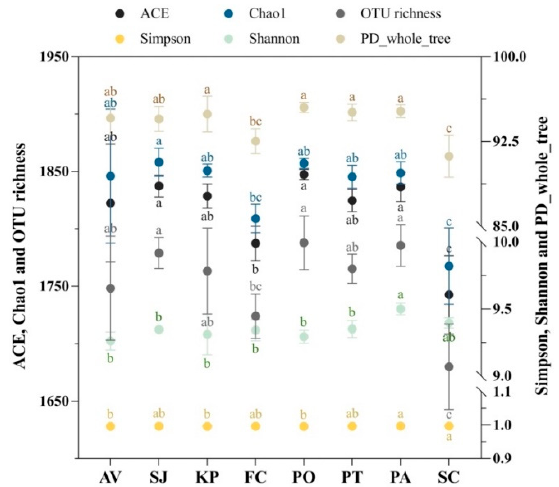
Figure 5. Rhizosphere bacterial community α -diversity in different stands. Data present means ± st. errors; different letters (from a to d) in figure body indicate significant differences among tree species after Duncan’s test ( p < 0.05), n = 3. (AV, A. vulgaris ; SJ, S. japonica ; KP, K. paniculata ; FC, F. chinensis